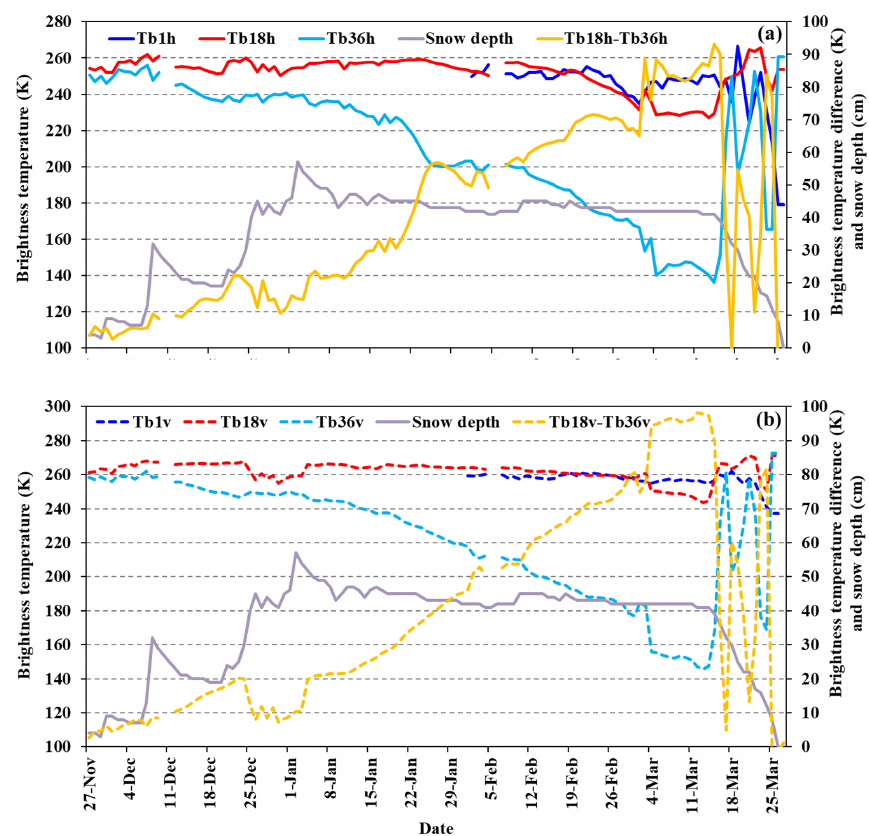
Figure 12. Daily variations in brightness temperatures at 1.4, 18, and 36GHz, for horizontal (Tb1h, Tb18h, Tb36h) and vertical (Tb1v, Tb18v, Tb36v) polarizations, the differences between Tb18h and Tb36h (Tb18h − Tb36h), and between Tb18v and Tb36v (Tb18v − Tb36v), at 01:00LT, from 27 November 2015 to 26 March 2016 (a) for horizontal polarization, and (b) for vertical